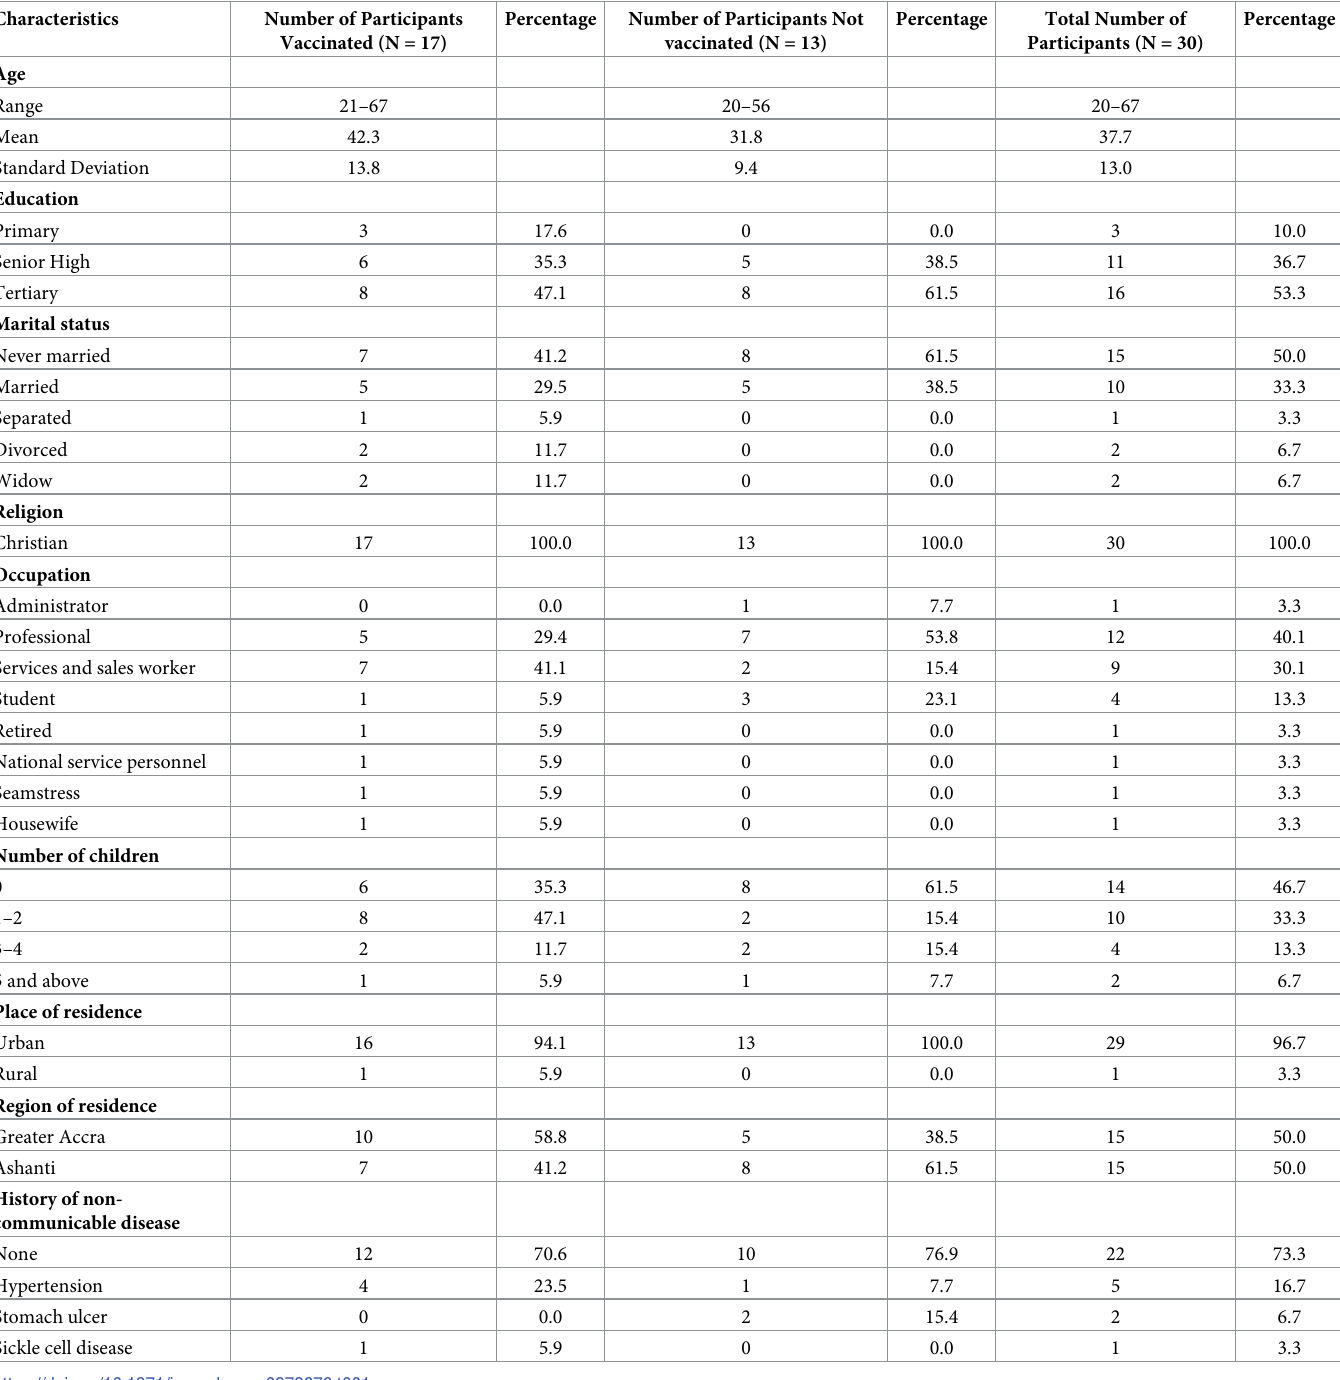
Table 1. Socio-demographic characteristics of